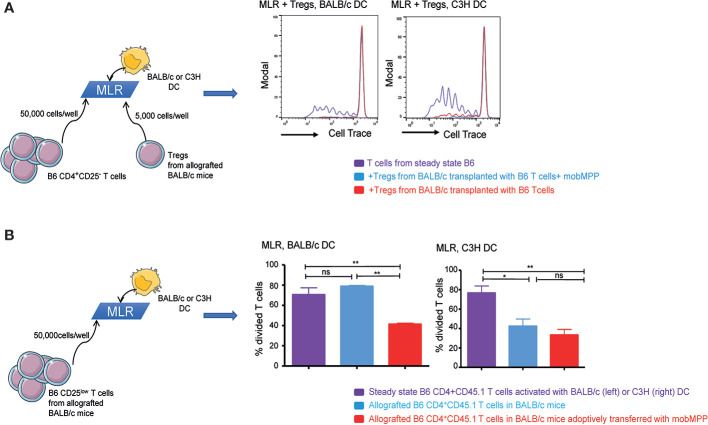
G-CSF mobilized MPP induce tolerance. (A) Steady state B6 CD4+CD45.1+ T cells activated by BALB/c (left) or C3H (right) DC were cultured alone (purple) or with Tregs in 10:1 ratio (50,000 T cells: 5,000 Tregs). Tregs were sorted from the spleen of allografted control BALB/c mice (red), or from allografted BALB/c mice with mobMPP (light blue) (n = 3). CFSE dilution within CD45.1+ T cells were compared. (One representative experiment out of 3). (B) Left: Steady state B6 CD4+CD25lowCD45.1+ T cells activated by BALB/c DC were analyzed for CFSE dilution (purple) and compared to CFSE dilution of allografted B6 CD4+CD25lowCD45.1+ T cells in BALB/c mice with (light blue) or without (red) adoptive transfer of mobMPP. Percentage of steady state B6 CD4+CD25lowCD45.1+ T cells in division is 70.57 ± 6.81% (purple) vs. 41.37 ± 1.03% (red), vs. 70.57 ± 6.81% (light blue), respectively **p ≤ 0.005 by one-way ANOVA with Tukey’s multiple comparisons test. Right: Steady state B6 CD4+CD25lowCD45.1+ T cells activated by C3H dendritic cells were analyzed for CFSE dilution (purple) and compared to CFSE dilution of allografted B6 CD4+CD25lowCD45.1+ T cells in C3H mice with (light blue) or without (red) adoptive transfer of mobMPP. Percentage of steady state B6 CD4+CD45.1 T cells in division is 76.60 ± 7.18% (purple) vs. 42.40 ± 7.35% (red), vs. 33.37. ± 5.69% (light blue), respectively, n = 3, (*p = 0.0275, **p = 0.0097; ns, not significant, by one-way ANOVA with Tukey’s multiple comparisons test).